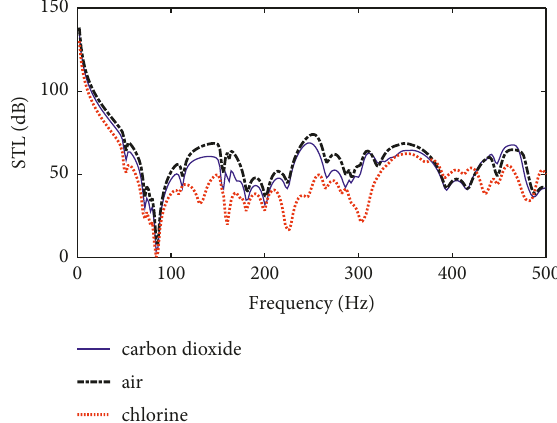
Figure 18: Sound transmission loss of the stiffened double panel- cavity coupled system with different length Lx 3.